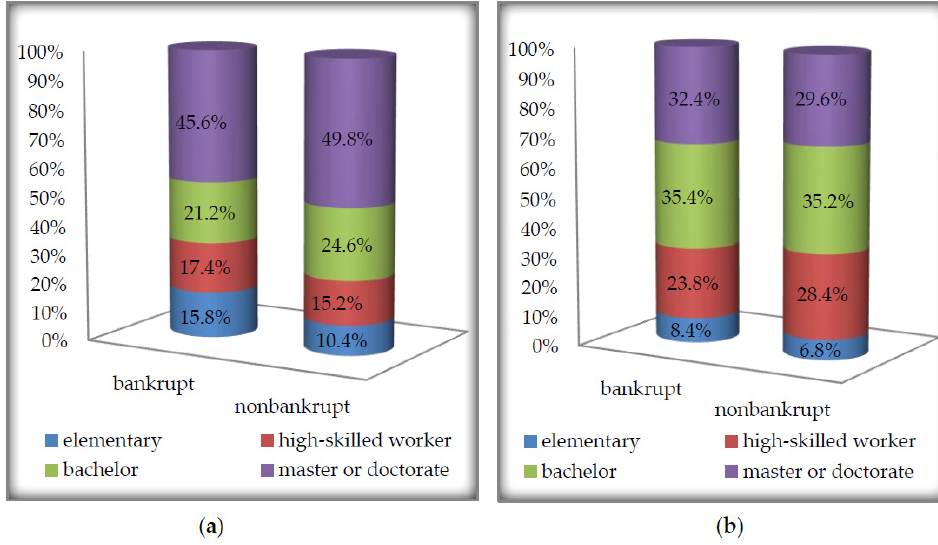
Figure 3. The education level structure of bankrupt and nonbankrupt consumers in the testing sample of: ( a ) Central Europe and ( b ) Far-East Asia. Source: Based on own studies.